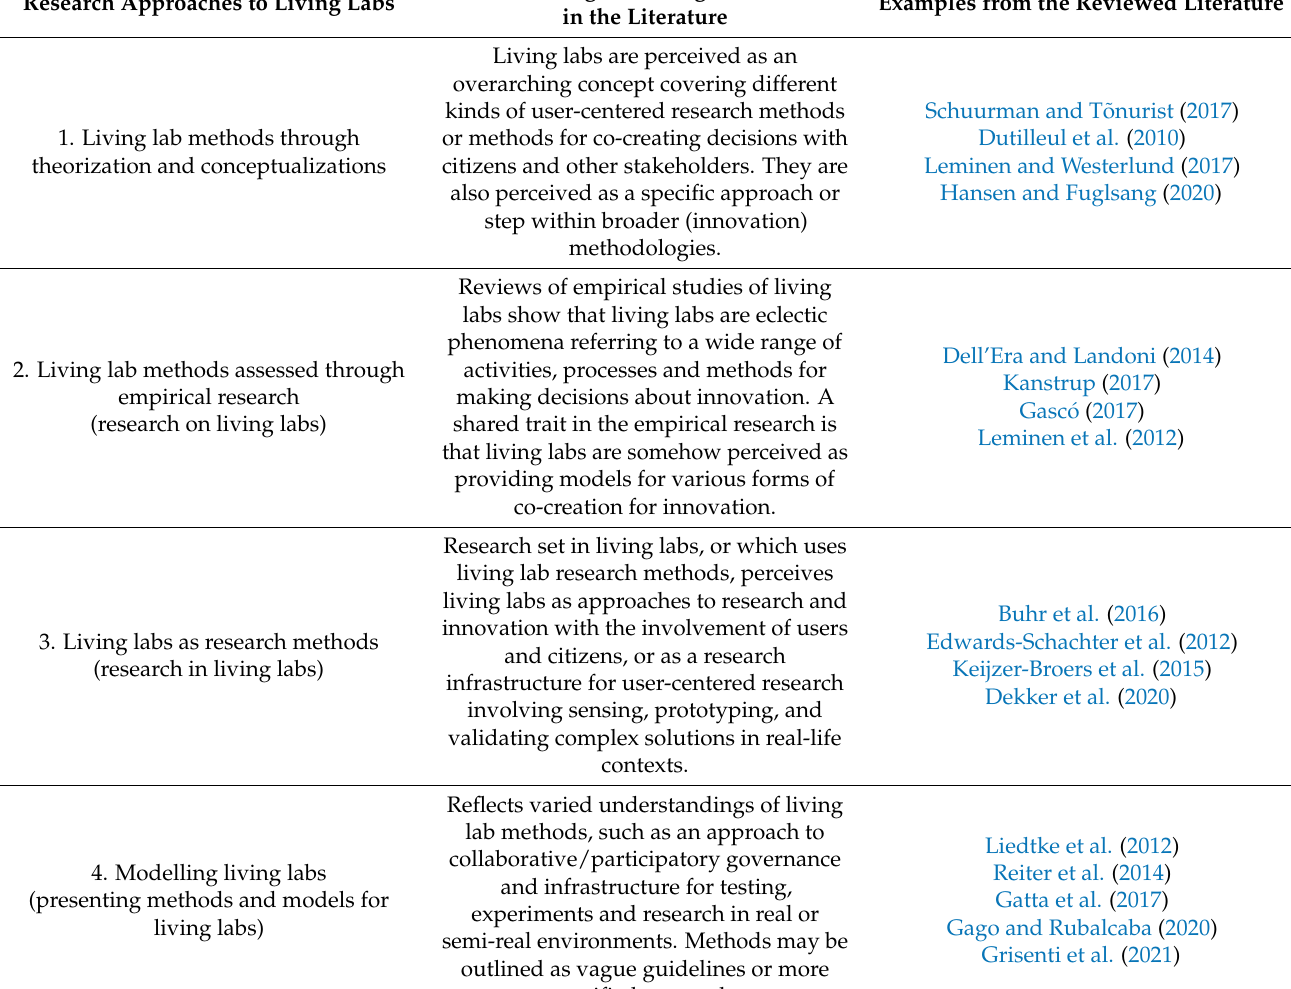
Table 2. Overview of how methodologies of living labs are addressed and understood in the